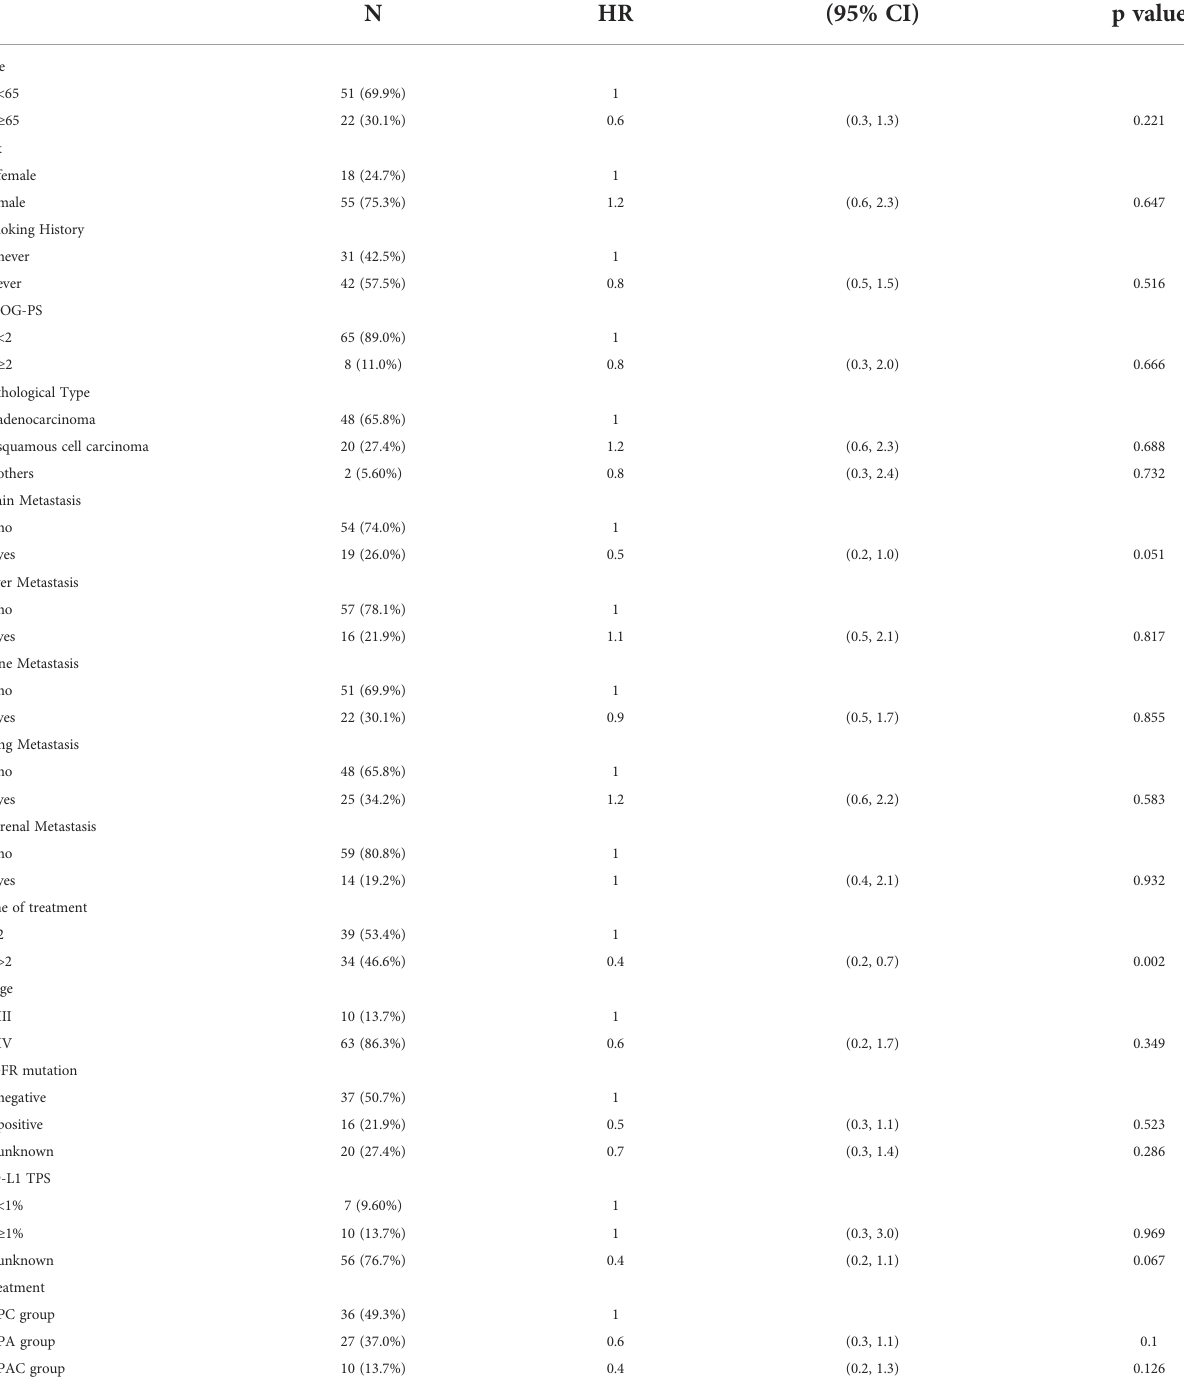
TABLE 3 Univariate cox regression analysis of clinical indicators to predict risk of